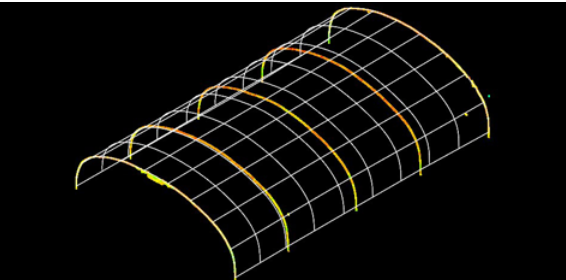
Figure 2. The spline surface obtained by five cross sections of the vault